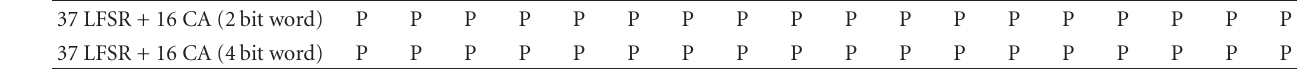
Table 6: Diehard results for modified throughput LFSR + CA and